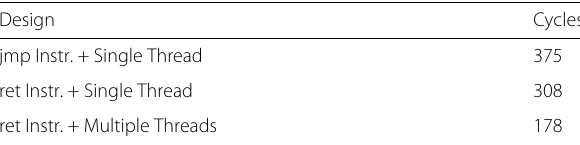
Table 2 Rand-store operation’s latency changes in different designs Design